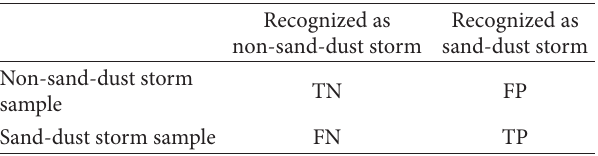
Table 3: Mixing matrix of sand-dust storm data set.